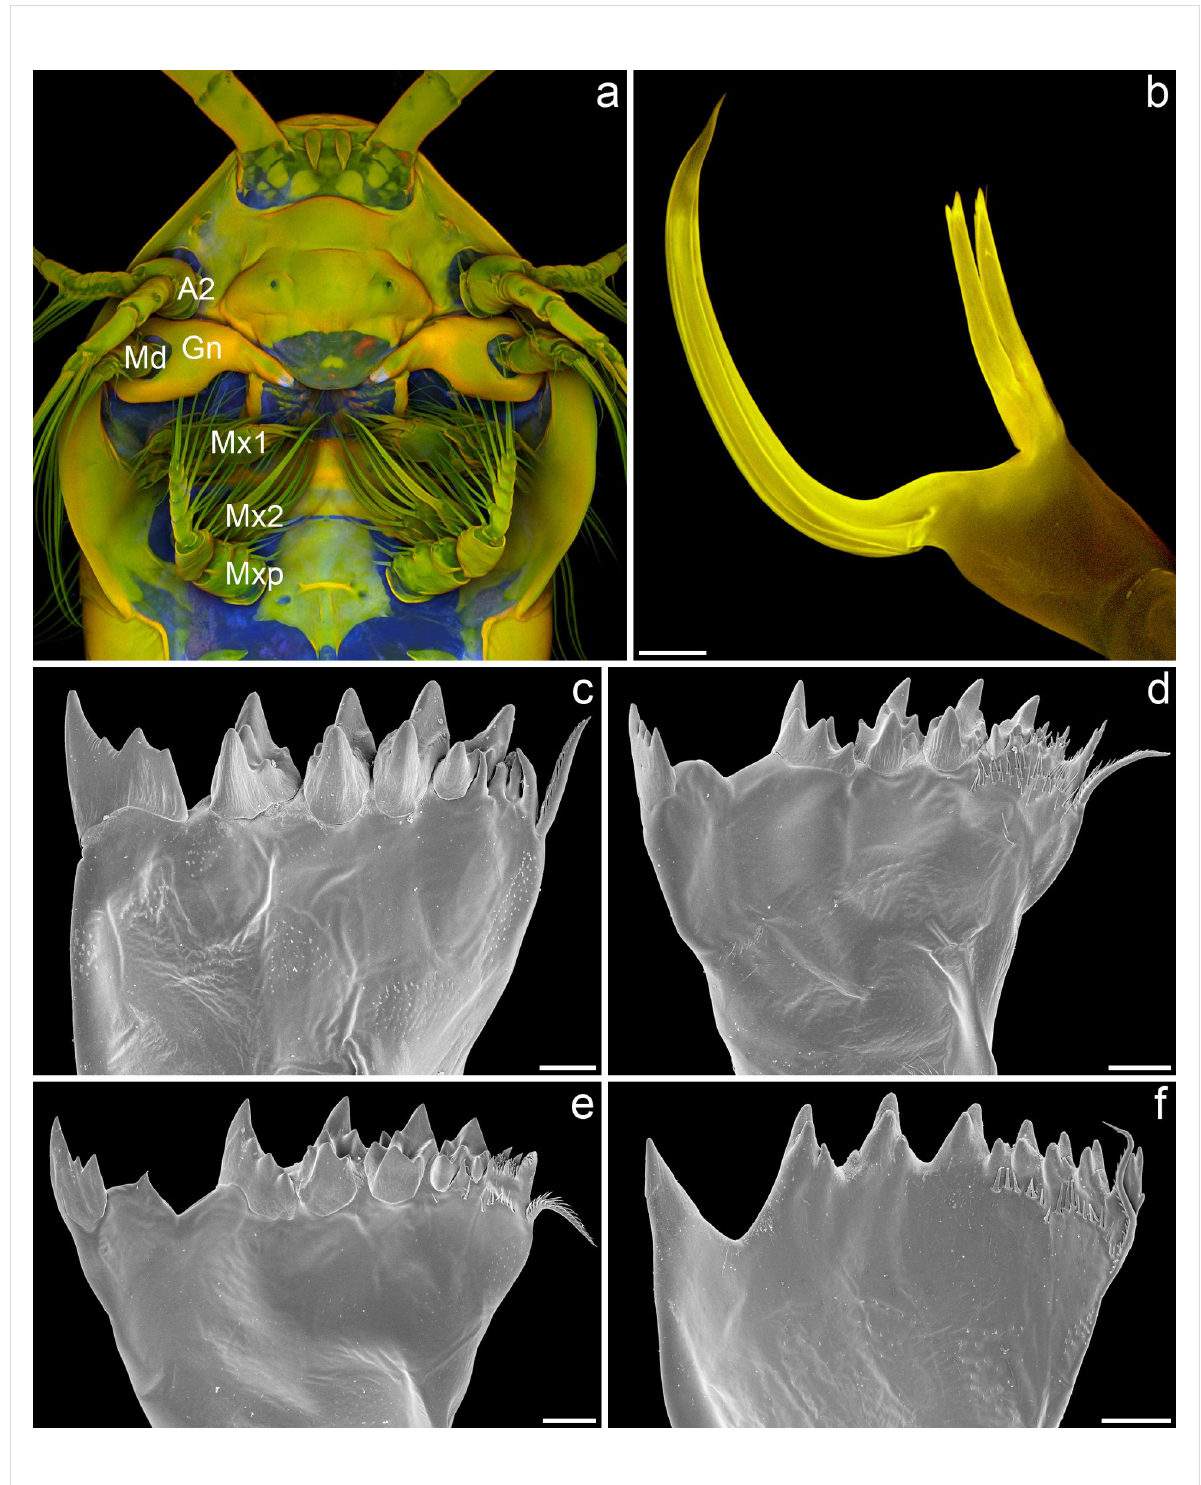
Figure 2: Mouthparts and different types of mandibular gnathobases of calanoid copepods. (a) Section of the micrograph shown in Figure 1d, indi- cating the location of the five pairs of mouthparts of Temora longicornis . A2 = second antenna, Md = mandible, Gn = mandibular gnathobase, Mx1 = first maxilla, Mx2 = second maxilla, Mxp = maxilliped. (Only one mouthpart of each pair is marked.) (b) Confocal laser scanning micrograph (maximum intensity projection) showing the left gnathobase of a male Heterorhabdus sp. from the Southern Ocean (cranial view). (c–f) Scanning electron micro- graphs showing the left gnathobases from females of different Antarctic copepod species (all cranial view). (c) Rhincalanus gigas . (d) Calanoides acutus . (e) Calanus propinquus . (f) Metridia gerlachei . Scale bars = 50 µm (b), 25 µm (c–e), 20 µm (f). (b) Adapted with permission from